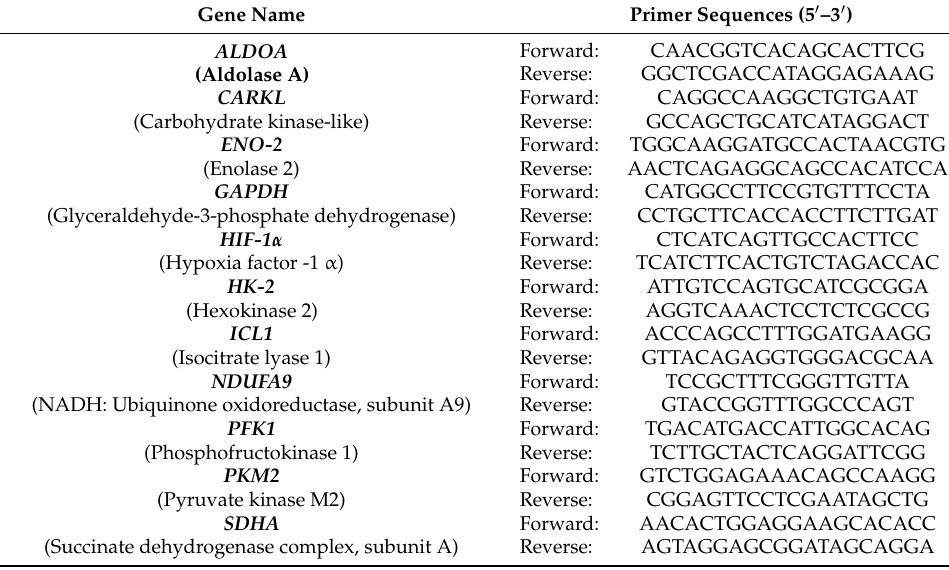
Table 1. Primers and their sequences used in this